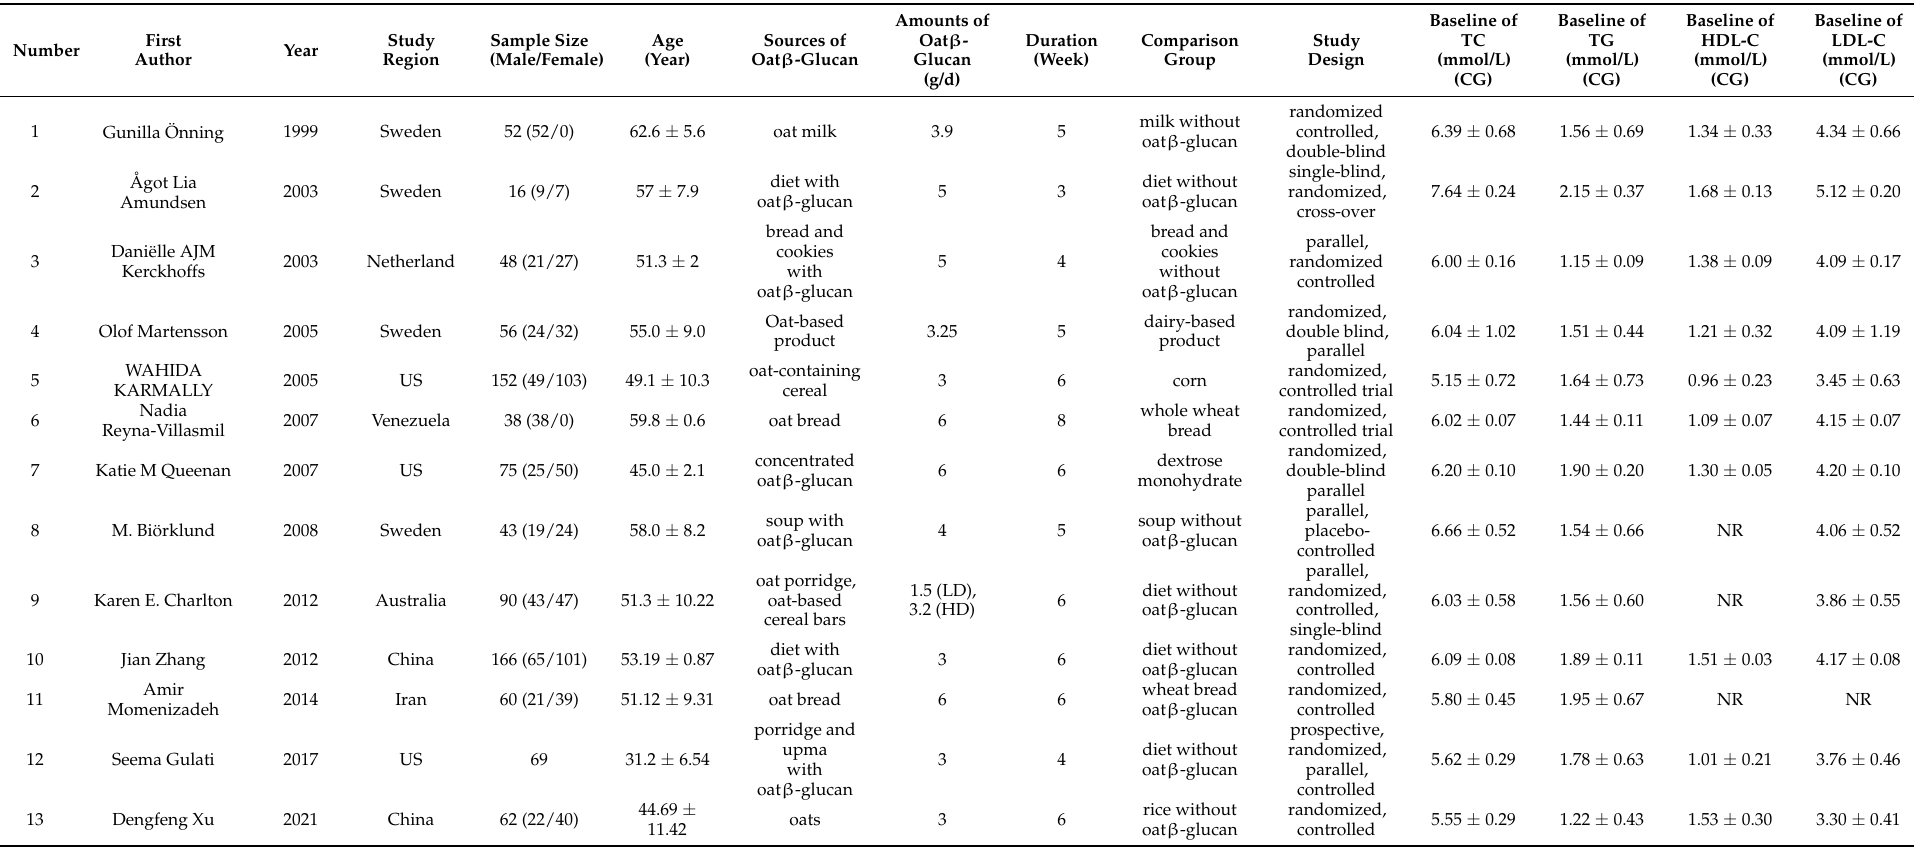
Table 1. Characteristics of included